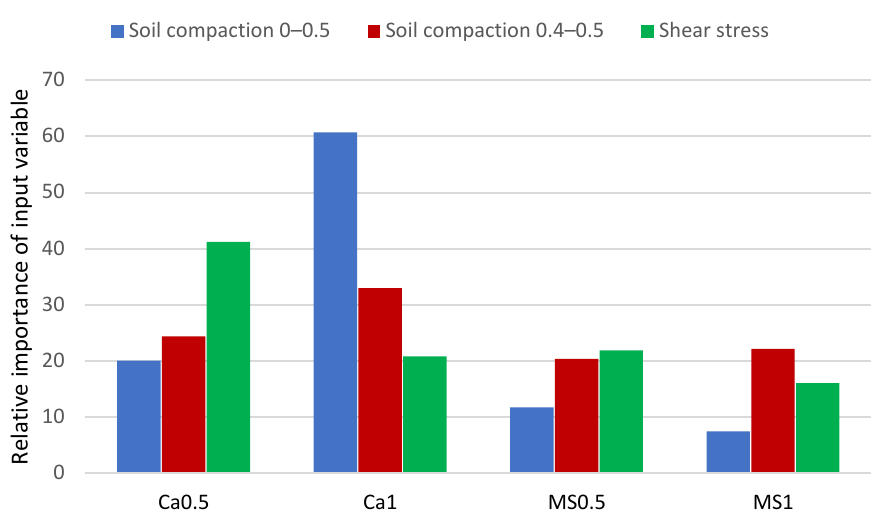
Figure 2. The relative importance of the input variables of the MLP model on soil compaction and shear stress.